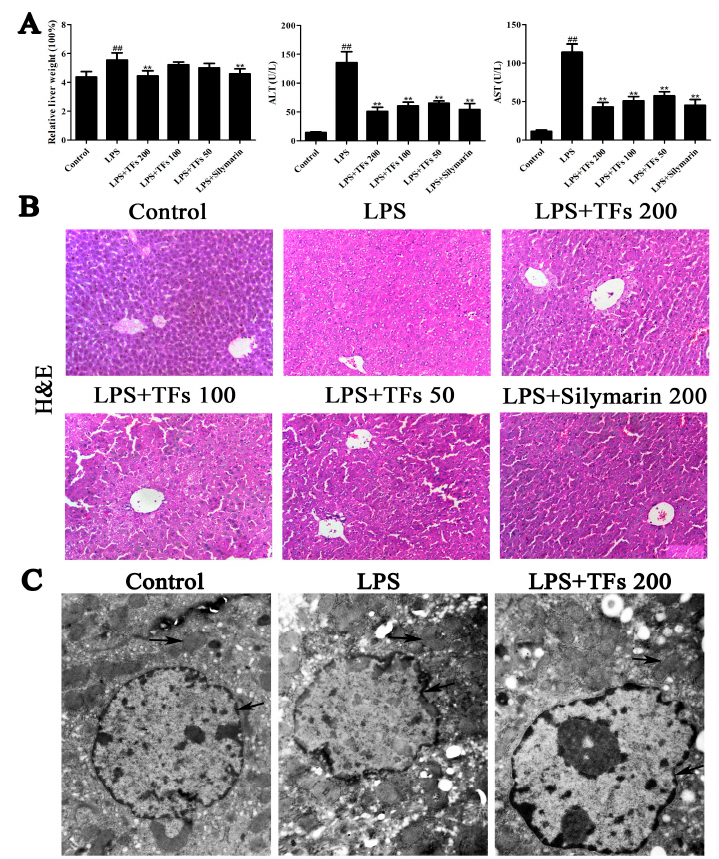
Figure 1. Effects of total flavonoids (TFs) on lipopolysaccharides (LPS)-induced liver injury and cellular structure changes in mice. ( A ) Effects of TFs on relative liver weight, serum ALT (alanine transferase) and AST (aspartate transaminase) activities. ( B ) Hematoxylin and Eosin (H&E) staining of liver tissues (200× magnification,). ( C ) TEM (transmission electron microscope) observations of the nuclei and mitochondria in liver cells (20,000 × magnification,). The values are expressed as the mean ± SD (standard deviation) ( n = 8); ## p < 0.01 versus control group; ** p < 0.01 versus model group.